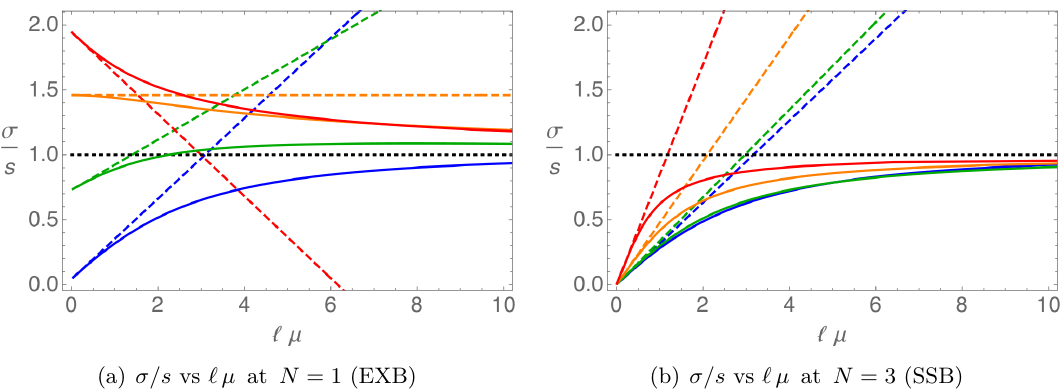
Figure 7 . Entanglement density at T/µ = 0 , m/µ = (2 , 1 , 0 . 5 , 0) (red, orange, green, blue). The black dotted line is the guide line for σ/s = 1 . Solid lines are numerical results σ/s via (2.18), dashed lines are analytic results: (4.14) in figure 7(a), (3.14) in figure 7(b). Note that the m/µ = 0 case corresponds to the blue data in figure